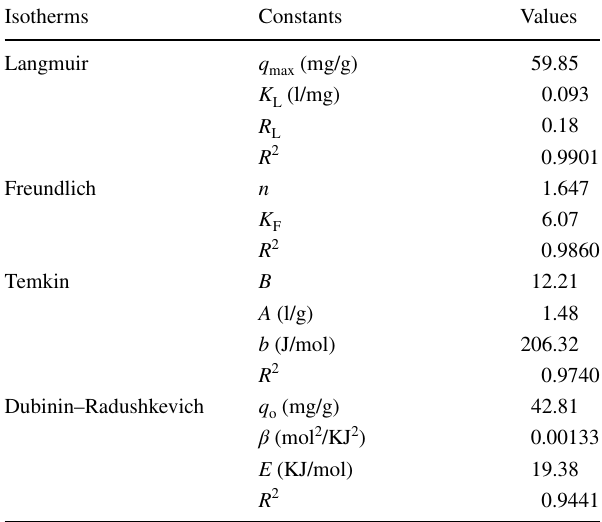
Table 1 Adsorption isotherm parameters for the uptake of Rh-B on AgNPs at 30